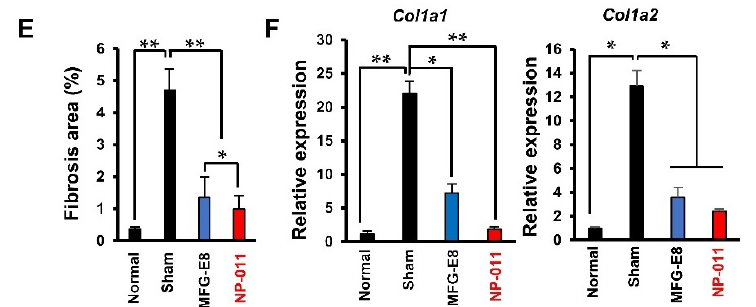
Figure 1. Production of truncated MFG-E8 and the advantages of NP-011 for treating liver disease. ( A ) Structural comparison of MFG-E8 and NP-011. ( B ) Confirmation of synthesized NP-011. Coomassie brilliant blue (CBB) staining and Western blot analysis showed ~25 kDa sized truncated forms of MFG-E8 (NP-011). The purity of the produced NP-011 protein (Batch #2) was analyzed by reverse-phase HPLC analysis. ( C ) Overall schematic schedule for testing the efficacy of the human recombinant proteins in a liver fibrosis model. The red arrow indicates the period for TAA administrations for inducing liver fibrosis. ( D ) Representative images of histological analysis (H&E and Sirius red staining) for the liver of normal mice, a TAA-induced liver fibrosis model (Sham), and a protein (MFG-E8, NP-011) administered liver fibrosis model. Scale bar, 200 μ m. ( E ) Comparison of the quantitative fibrotic area in the livers of the mice. ( F ) Comparison of mRNA expression for fibrotic markers ( Col1a1 , Col1a2 ) in the liver of normal mice, a TAA-induced liver fibrosis model (Sham), and a protein (MFG-E8, NP-011) administered liver fibrosis model. Bars represent the means ± SD from three replicates in each group. * p < 0.05, ** p < 0.01, ANOVA followed by Tukey’s multiple comparison test.